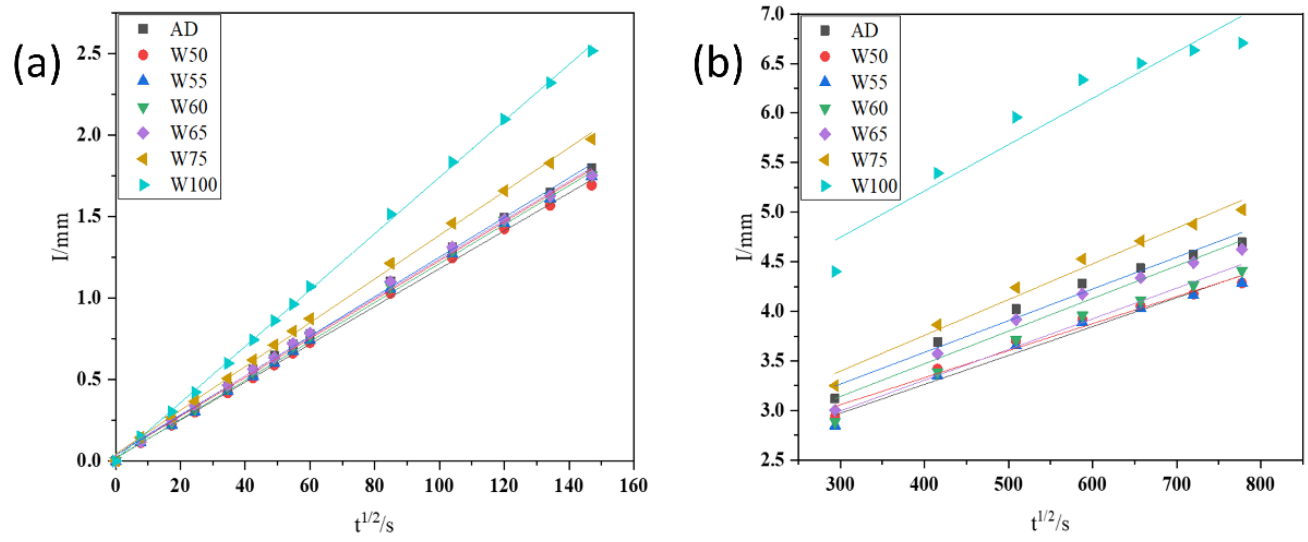
Figure 10. Water adsorption of recycled concrete at the initial time (6 h) ( a ) and secondary time (7 d) ( b ).